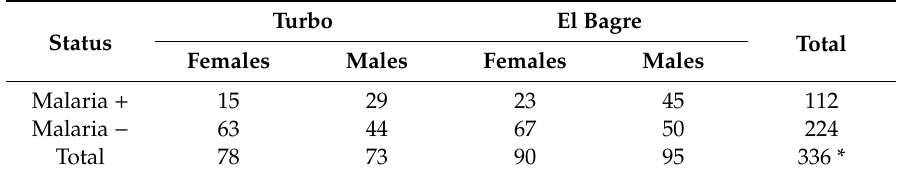
Table 3. Demographic description of the individuals from which serum samples originated, categorized by malaria diagnosis, malaria positive ( + ) or malaria negative ( − ), and sex. Turbo El Bagre Status Total Females Males Females Males Malaria + 15 29 23 45 112 Malaria − 63 44 67 50 224 Total 78 73 90 95 336